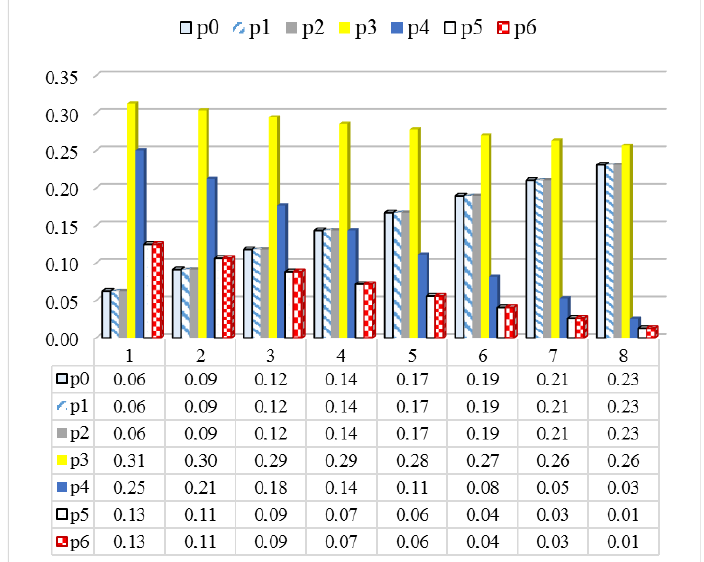
Figure 8. Statistical sample of the final probabilities for the controllable parameters b = 0.5 and a = {1 = 0.2; 2 = 0.3; 3 = 0.4; 4 = 0.5; 5 = 0.6; 6 = 0.7; 7 = 0.8; 8 = 0.9}.